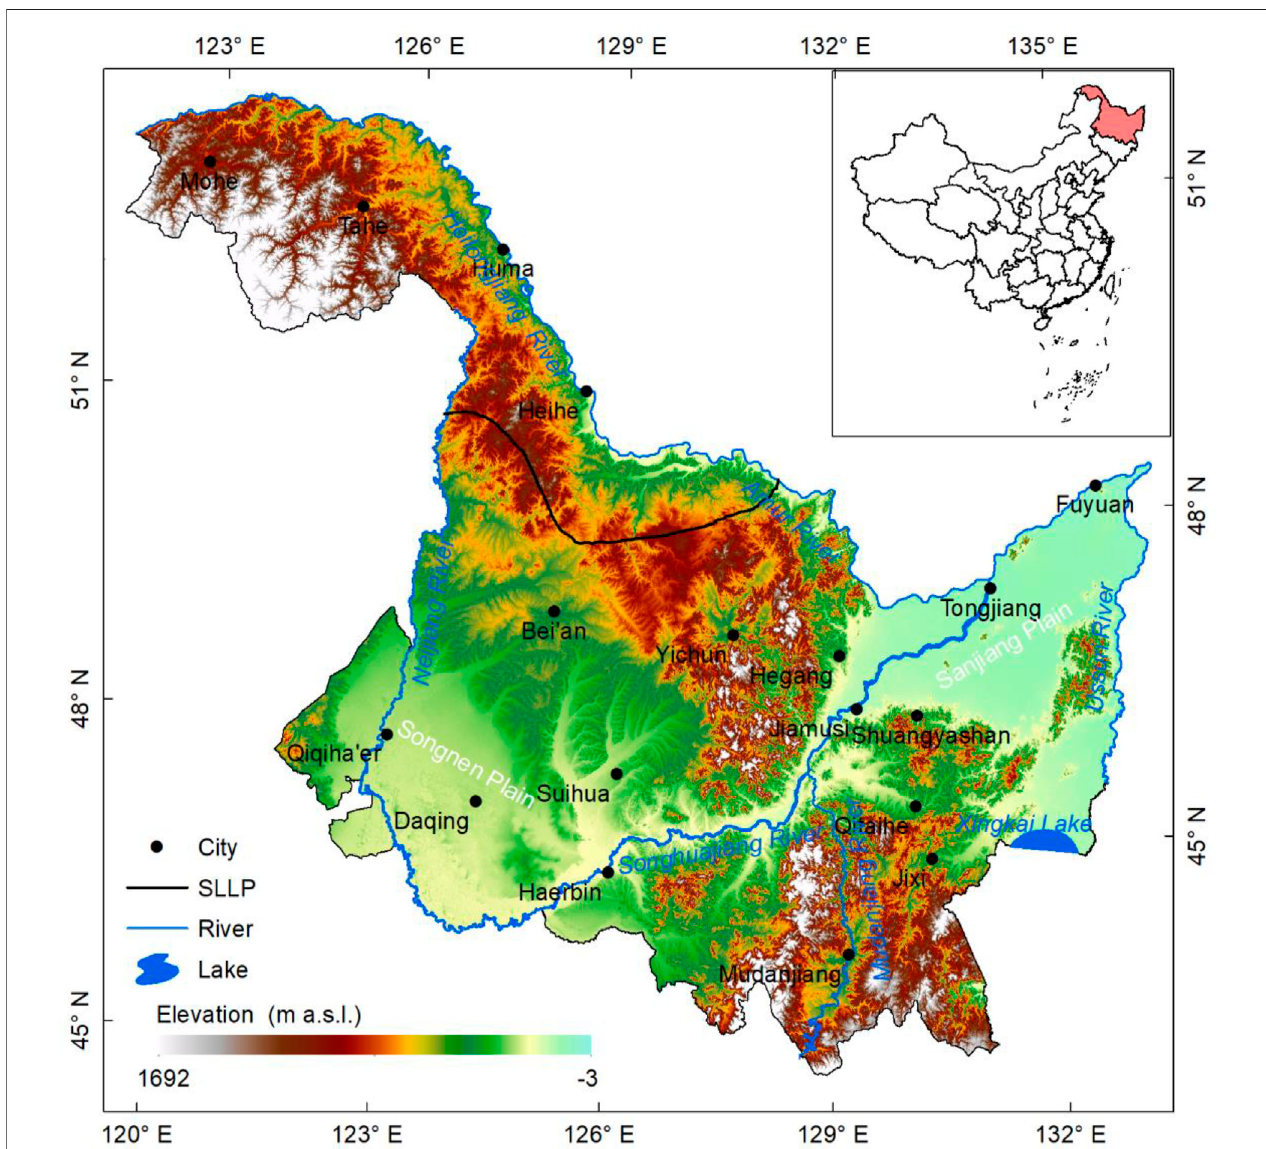
FIGURE 1 | The study region (Heilongjiang Province) in Northeast China. The SLLP means Southern limit of latitudinal permafrost.